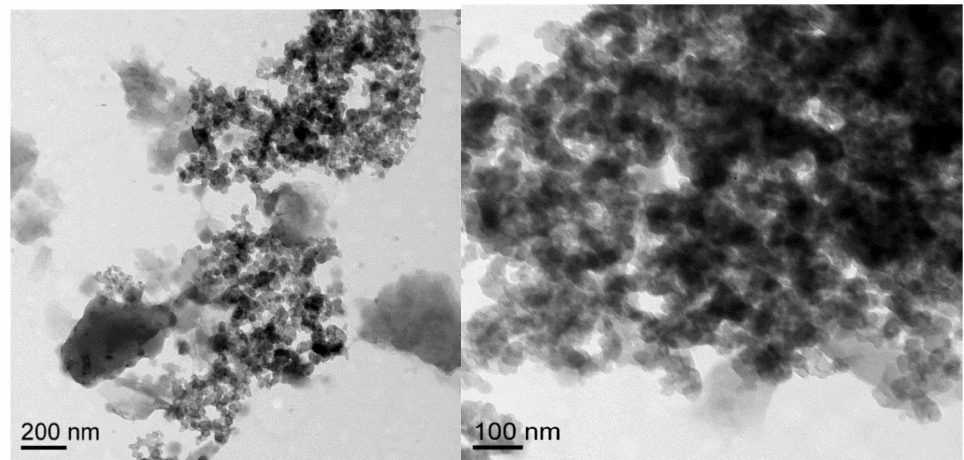
Figure 4. TEM images of the bulk RCMD sample from the bolter after sample preparation and before injection to the FFF